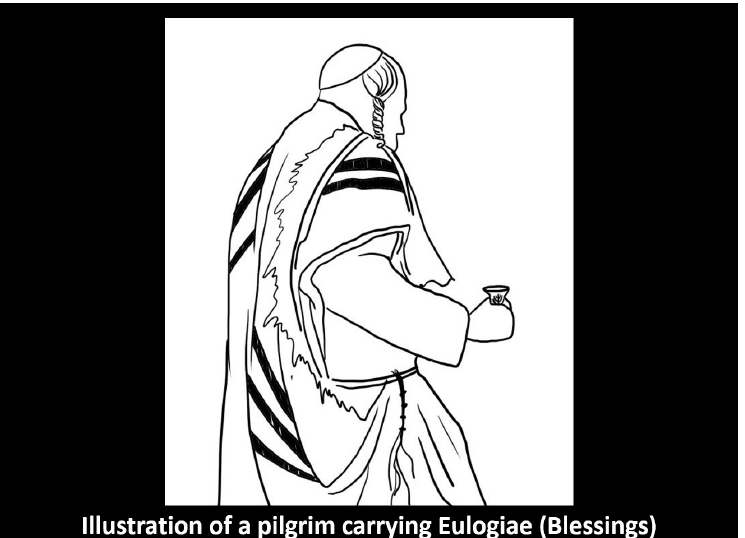
Figure 10. An illustration of the act of using Eulogiae created to explain the use of the Glass Jars with Menorah symbol.